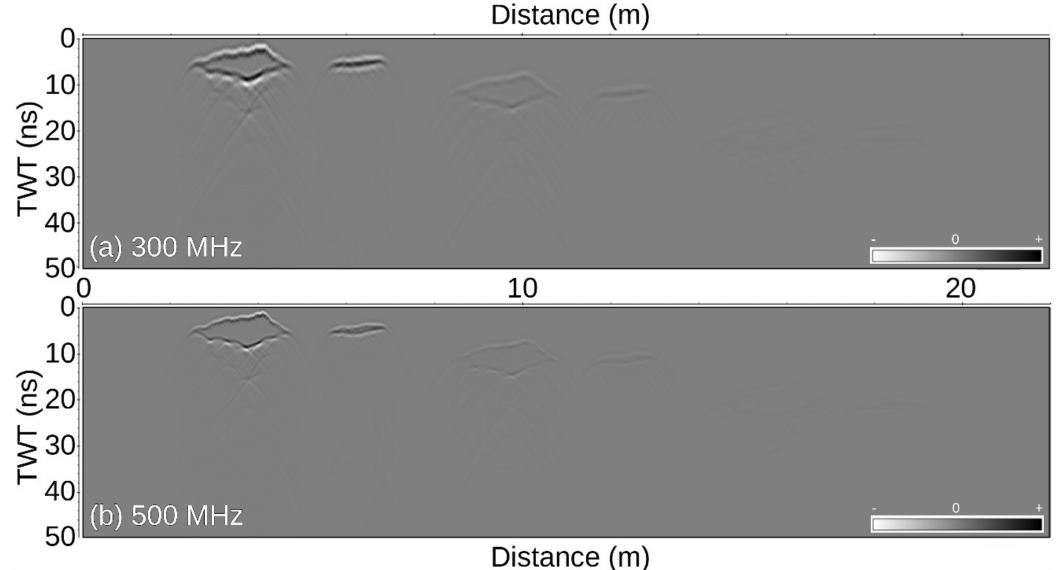
Figure 8. GPR synthetic data derived from model 1, simulating fossils layers including cololites and fossiliferous beds located at increasing depth, and assuming a flat topography; ( a ) synthetic data from 300 MHz simulation displaying how the shallow reflections are clearly visible, whilst the deeper ones result in being progressively attenuated so that the deeper one is almost invisible; ( b ) synthetic data from 500 MHz simulation displaying the reflections as in ( a ), but characterized by higher solution (display does not include any gain recovery function applied to